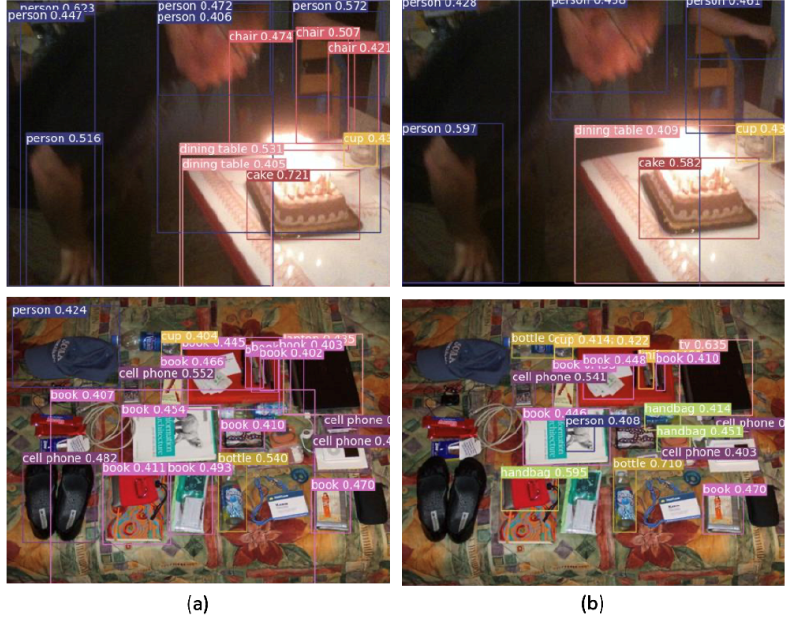
Figure 8. Detection results of ( a ) the conventional FCOS and ( b ) proposed method for the MS COCO 2017 minival